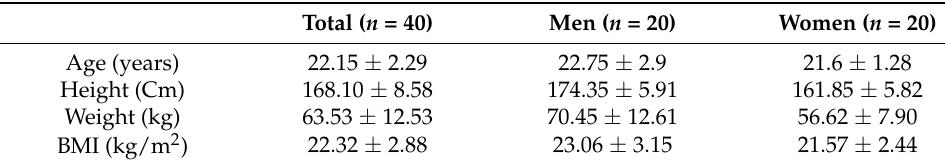
Table 1. General characteristics of